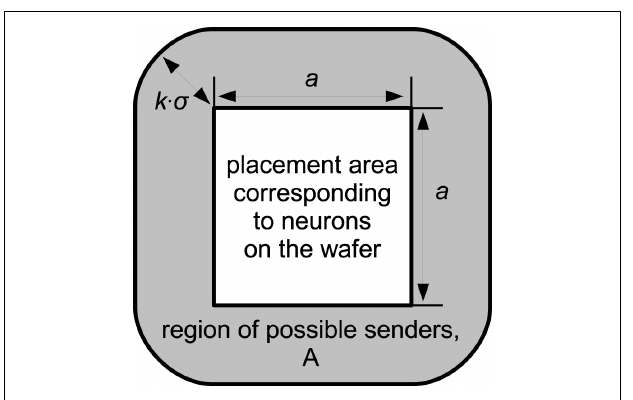
FIGURE 3 |Approximation for the region of senders to a single wafer for locally connected